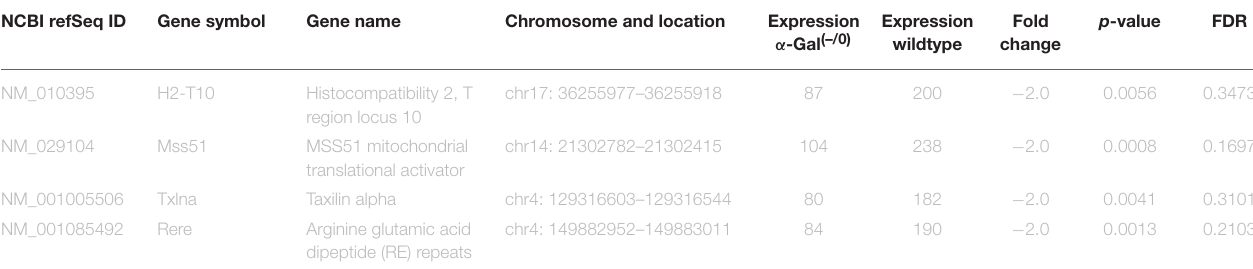
of HDAC inhibitors have been investigated for Niemann-Pick type C (Helquist et al., 2013) and Gaucher disease (Lu et al., 2011). Regarding FD, evidence is available from transgenic mouse fibroblasts overexpressing a human α -Gal A mutation that HDAC inhibition rescues α -Gal A trafficking blockade, but without an effect on lysosomal Gb3 storage (Yam et